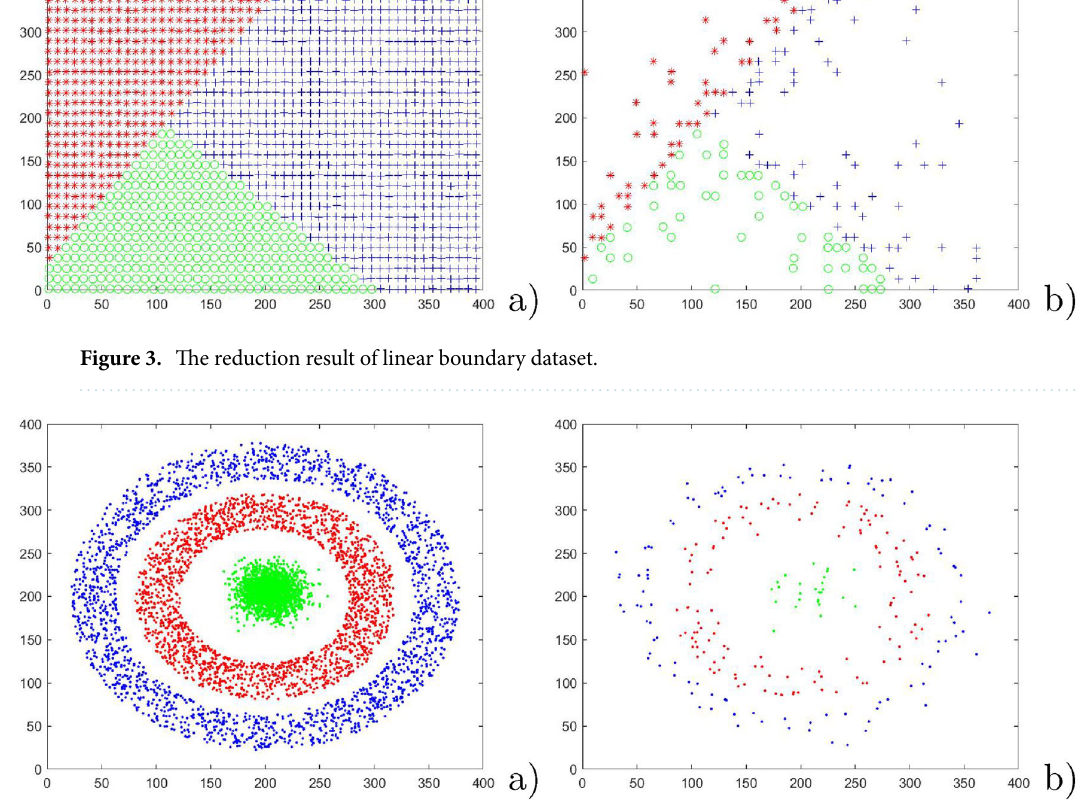
Figure 4. The reduction result of circular boundary dataset.